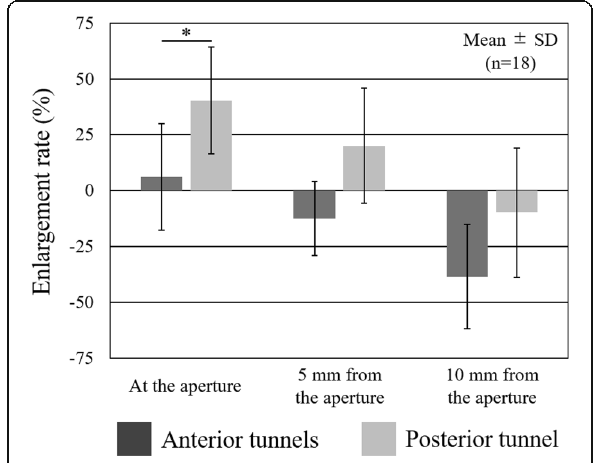
Fig. 4 Tunnel enlargement rate in the tibial tunnels. The enlargement rate in the posterior tunnel was significantly greater than that in the anterior tunnels at the aperture site